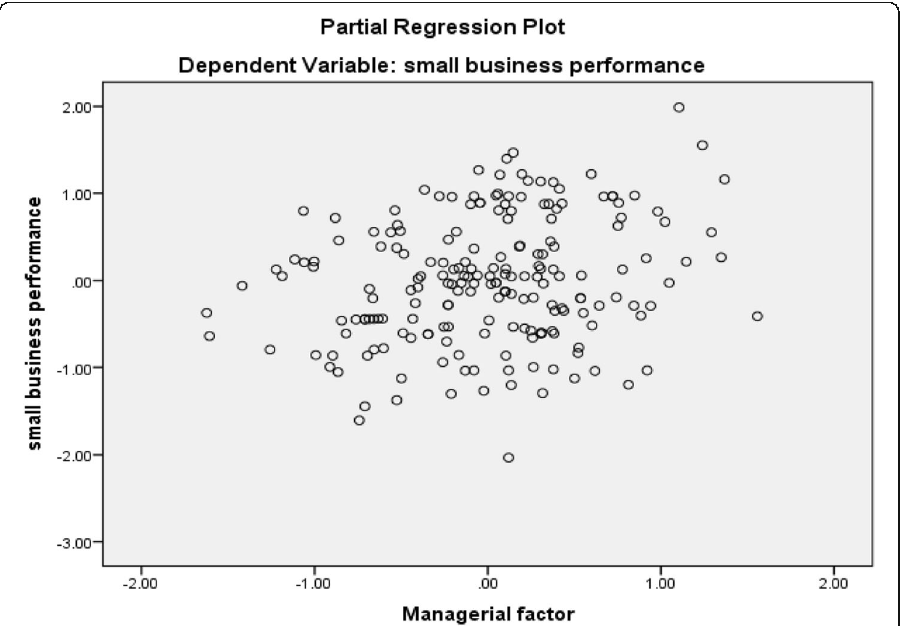
Fig. 4 Partial regression plot of independent variable managerial factor